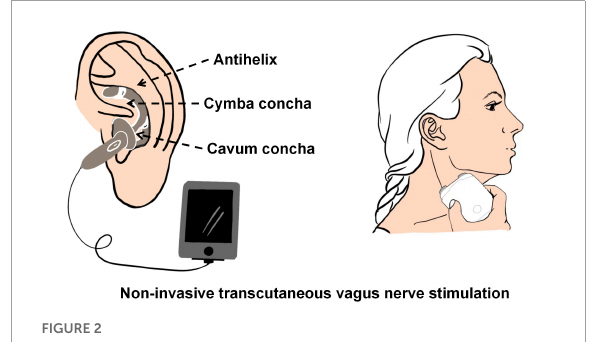
FIGURE2 The schematic of transcutaneous cervical vagus nerve stimulation (tcVNS) and transcutaneous auricular vagus nerve stimulation